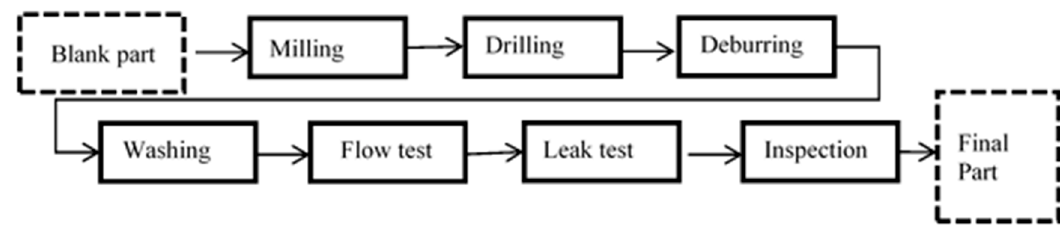
Figure 2. Engine head production process. Figure 2 . Engine head production process. Figure 2 . Engine head production process.